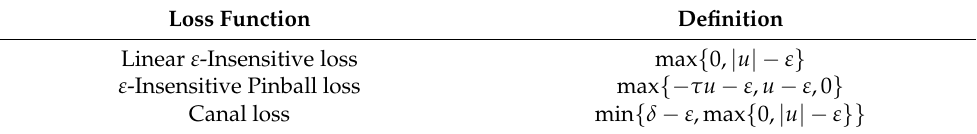
Table 1. Loss functions.